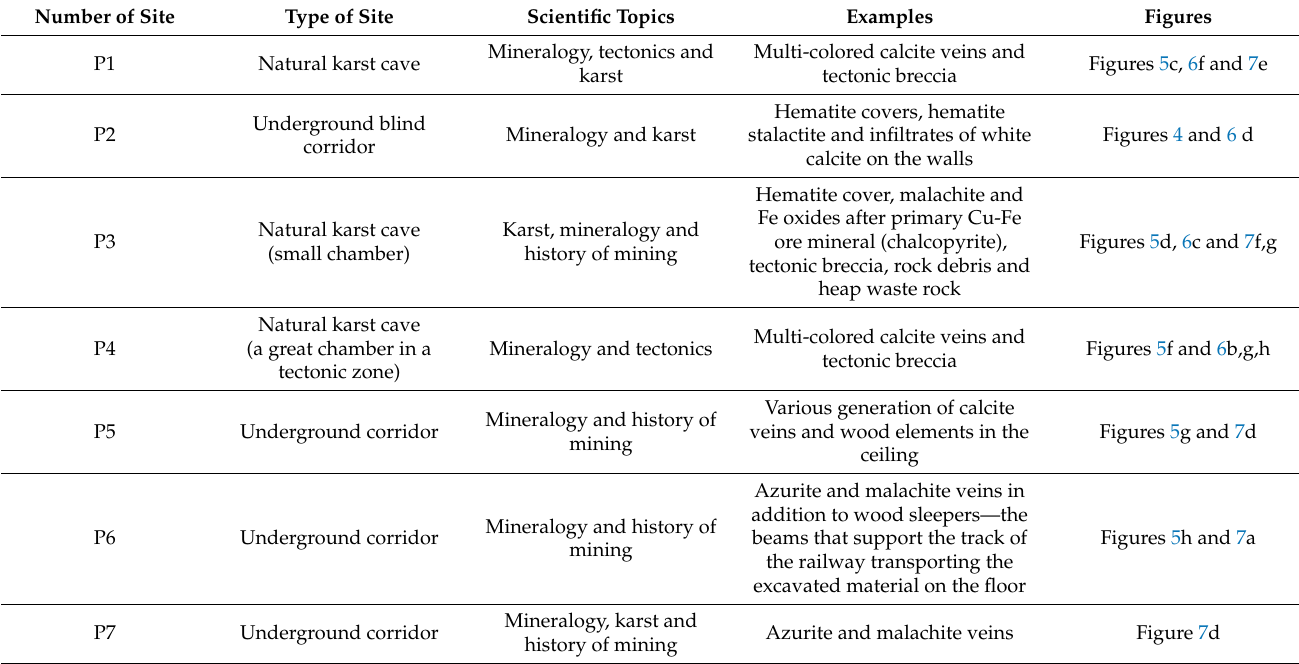
Table 1. List of representative sites in the Teresa adit with examples from scientific topics. Number of